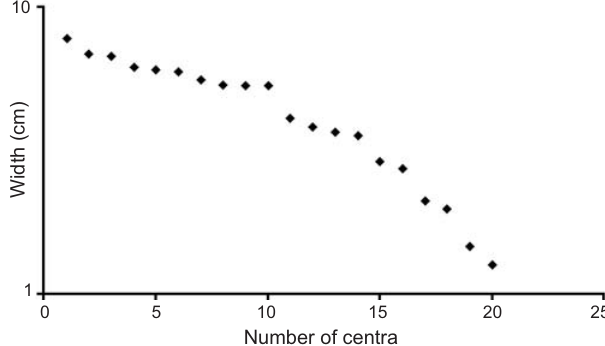
Fig. 8. Graphic representation of vertebral size decrease in Carcharomodus escheri (Agassiz, 1843) from anterior to posterior. Steps at positions 10-11, 14-15 and 18-19 indicate missing portions due to collecting and/or tapho- nomic artefacts.